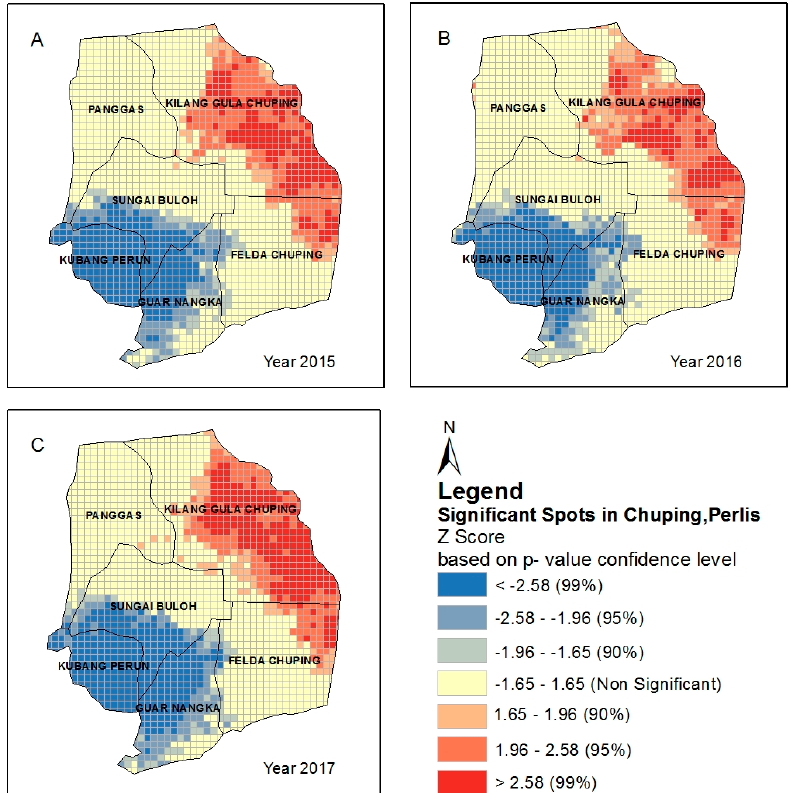
Figure 8. Regression analysis of NDWI against TVDI for the year 2015 ( A ), 2016 ( B ) and 2017 ( C ) in the month of March where clustered significant spots are identified with 90%, 95% and 99% accuracy are shown using Z